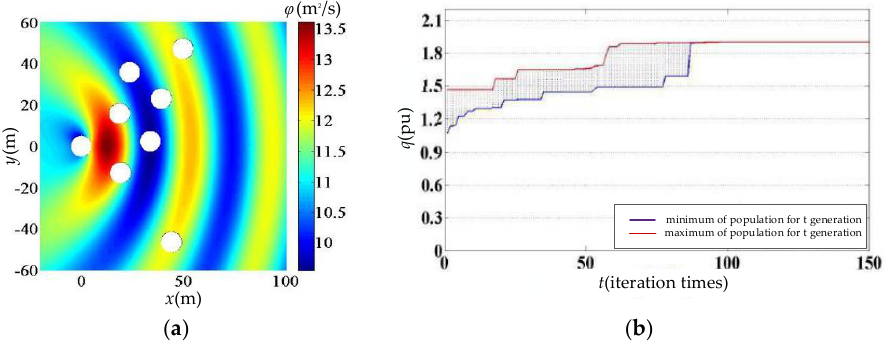
Figure 10. Optimal results for the eight-float array: ( a ) the optimal position; ( b ) individual fitness values for each generation.